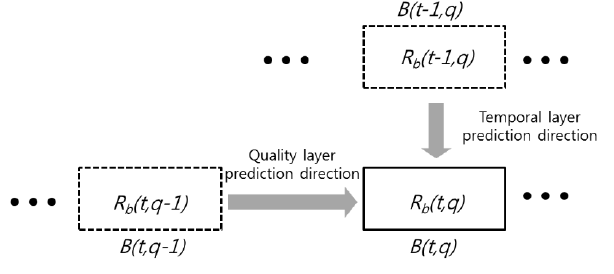
Figure 6. Prediction structure of R b ( t , q ) in the scalable video coding structure.